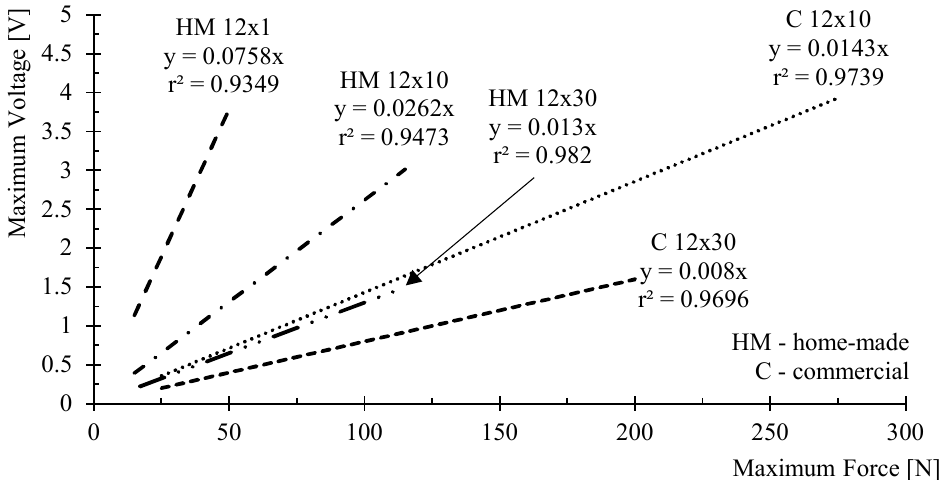
Figure 9. The comparison of the calibration lines and sensitivities for the home-made PVDF sensors and commercial PVDF sensors for different sensors active areas.